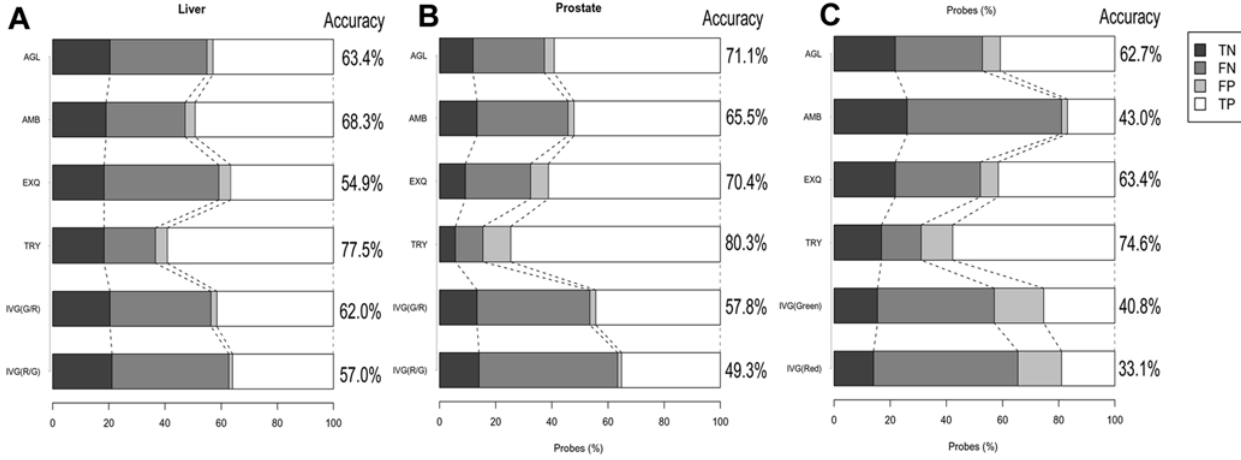
Figure 7. Agreement of microRNA list between microarray platforms and the Taqman assay. MicroRNAs that were listed, or not listed in both microarray and the Taqman assay, were considered as true positive (TP) or true negative (TN), respectively. MicroRNAs that were listed in either microarray or Taqman assays, were handled as false positive (FP) or false negative (FN), respectively. 7A and B : These graphs indicated the concordance of detection call between microarray platforms and the Taqman assay, using 142 microRNAs assayed by both microarray and the Taqman system. 7C : This bar graph demonstrated the concordance of microRNAs identified as differentially expressed between microarray platforms and the Taqman assay system.